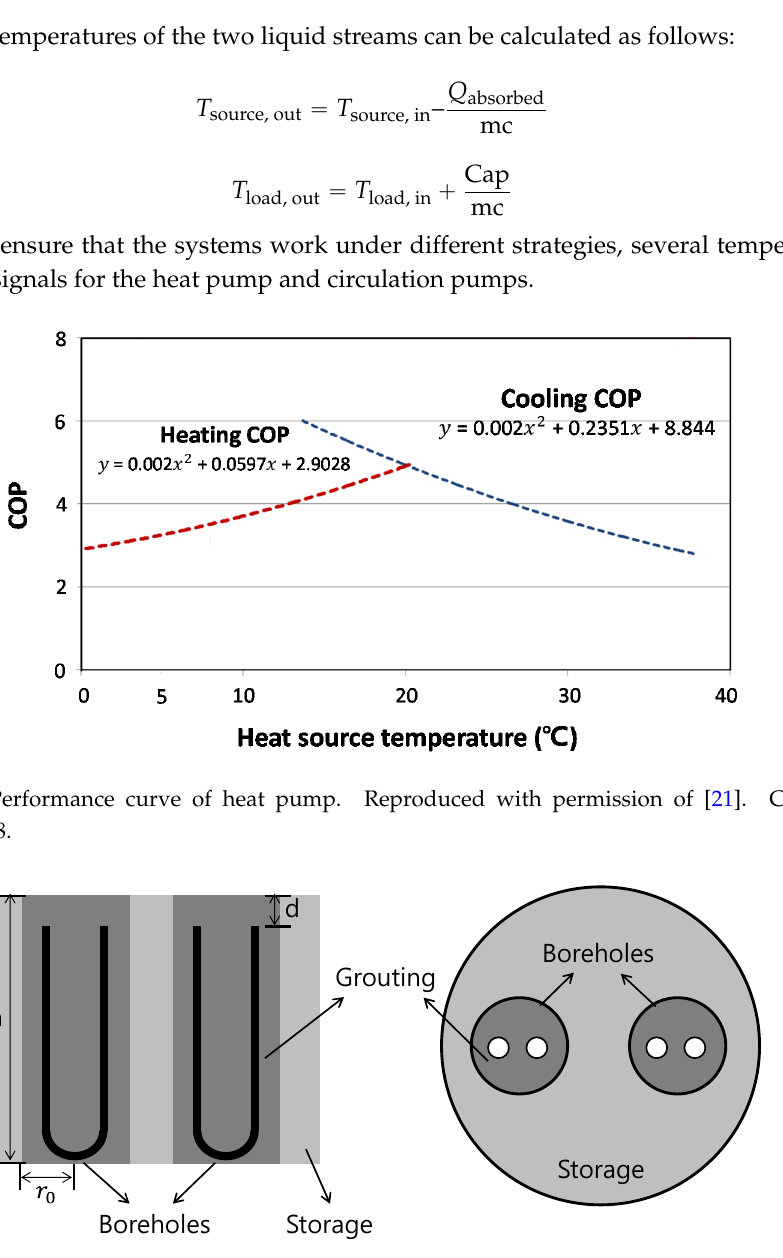
Figure 5. Conceptual diagram of the DST model. Reproduced with permission of [20]. Copyright TRNSYS, 2015.